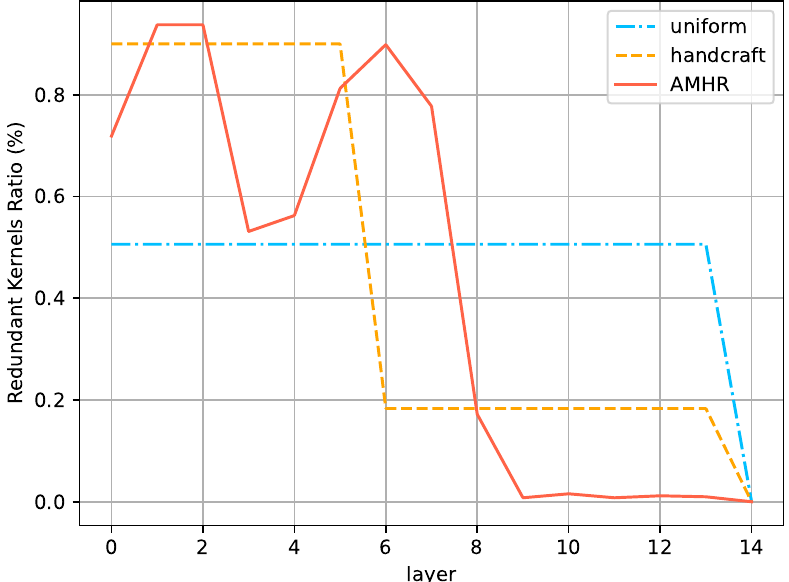
Figure 9. Redundant kernels ratio among layers in SSD-VGG16 using different hardening